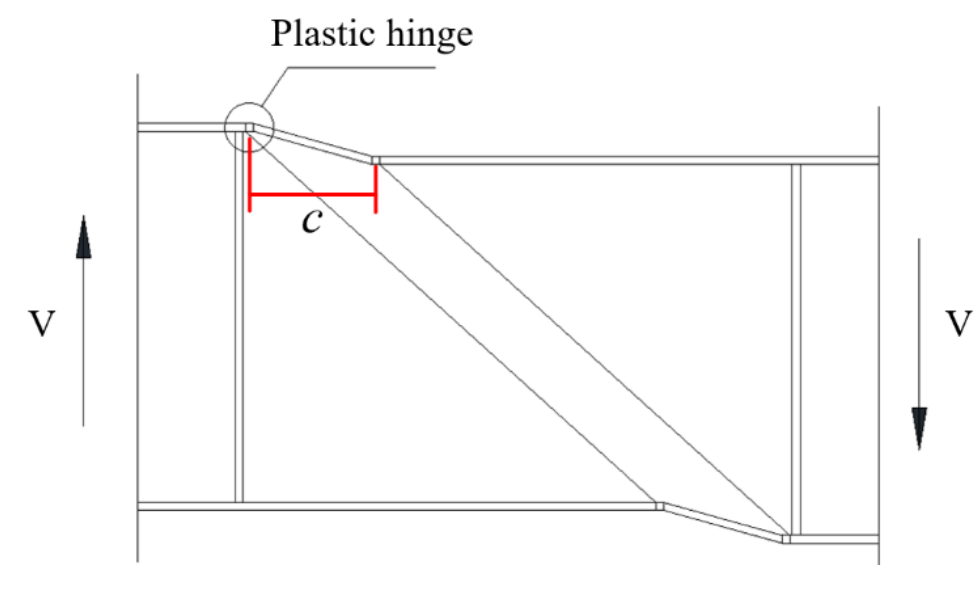
Figure 14. Tension field mechanism for post-buckling stage.